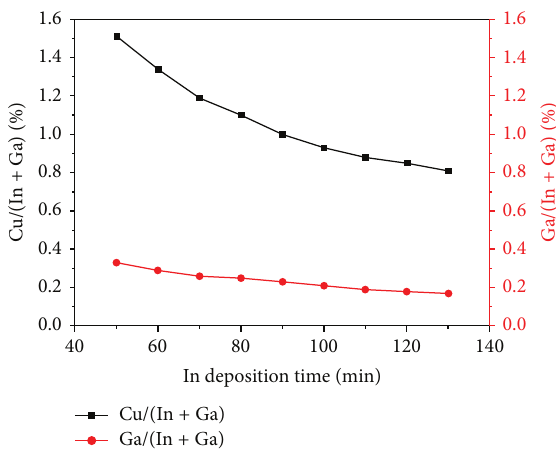
Figure 1: The atomic composition ratios of In/Cu-Ga precursors as a function of In deposition time.